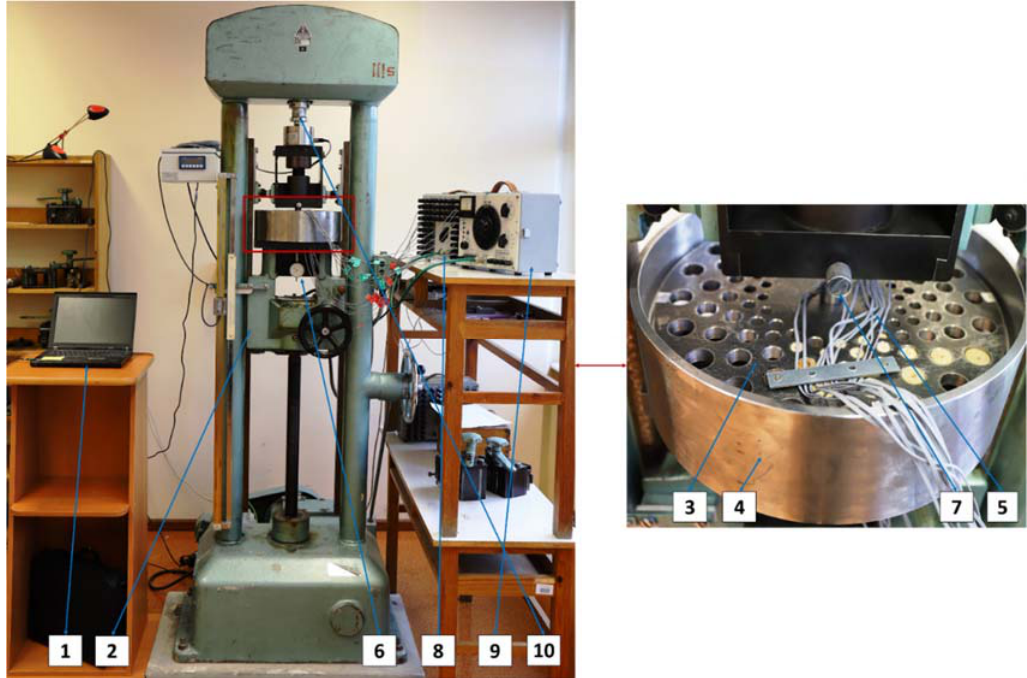
Figure 6: View of the testing machine prepared for testing in the case of plate loading with concentrated force P, where: 1 - computer, 2 - universal testing machine, 3 - steel-titanium circular axially symmetrical perforated plate, 4 - annular support, 5 - strain gauge, 6 - sensor dial, 7 - pressure pin, 8 - distribution box, 9 - strain gauge bridge, 10 - dial gauge.